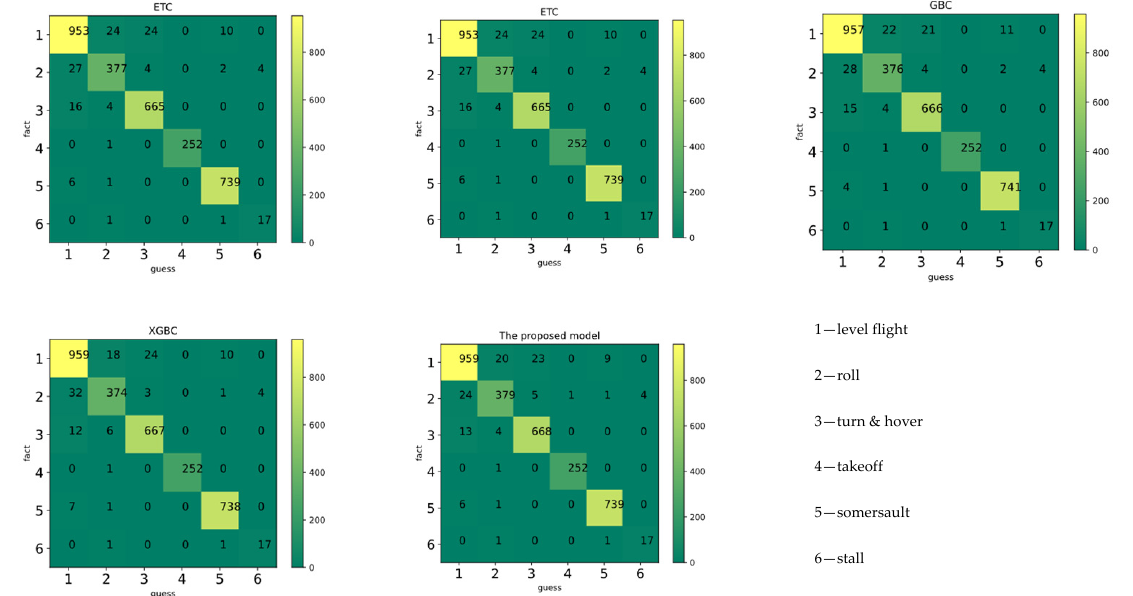
Figure 6. Kendall correlation analysis.